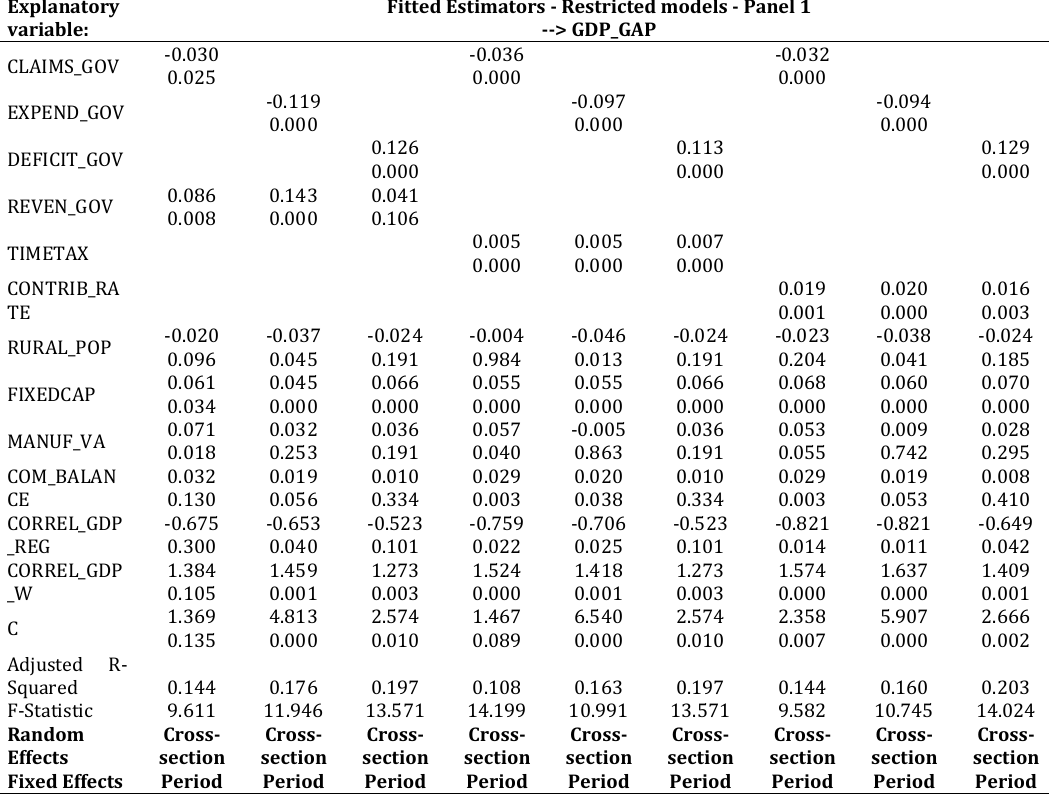
Table 6: Fitted estimators with random effects / fixed effects – Panel 1 (dependent variable GDP gap) Explanatory